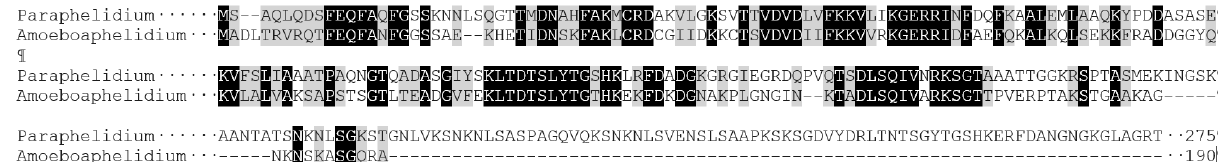
Figure 4. The phylogenetic tree of some TPPPs constructed by Bayesian analysis [16]. The number of generations was 1.4 × 10 − 6 . Full and open circles at a node indicate that the branch was supported by the maximal Bayesian posterior probability (BPP) and ≥ 0.95 BPP, respectively. All the other branches were supported by BPP ≥ 0.5. The accession numbers of proteins are listed in Table S3. Uppercase le tt ers indicate animal-type TPPPs, lowercase le tt ers indicate fungal-type ones, except for the outgroup Tetrahymena thermophila TPPP (XP_001023601) (phylum Ciliophora), which is a short-type TPPP. Fungal phyla are indicated by bold le tt ers.